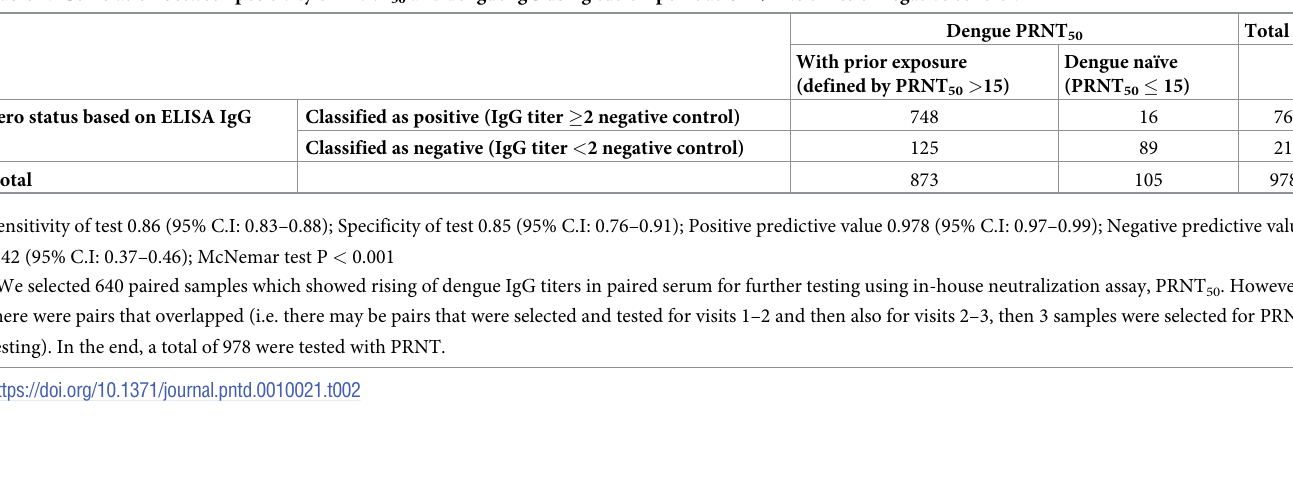
Table 2. Correlation between positivity of PRNT 50 and dengue IgG using cut-off point at OD > 2.0 times of negative control.